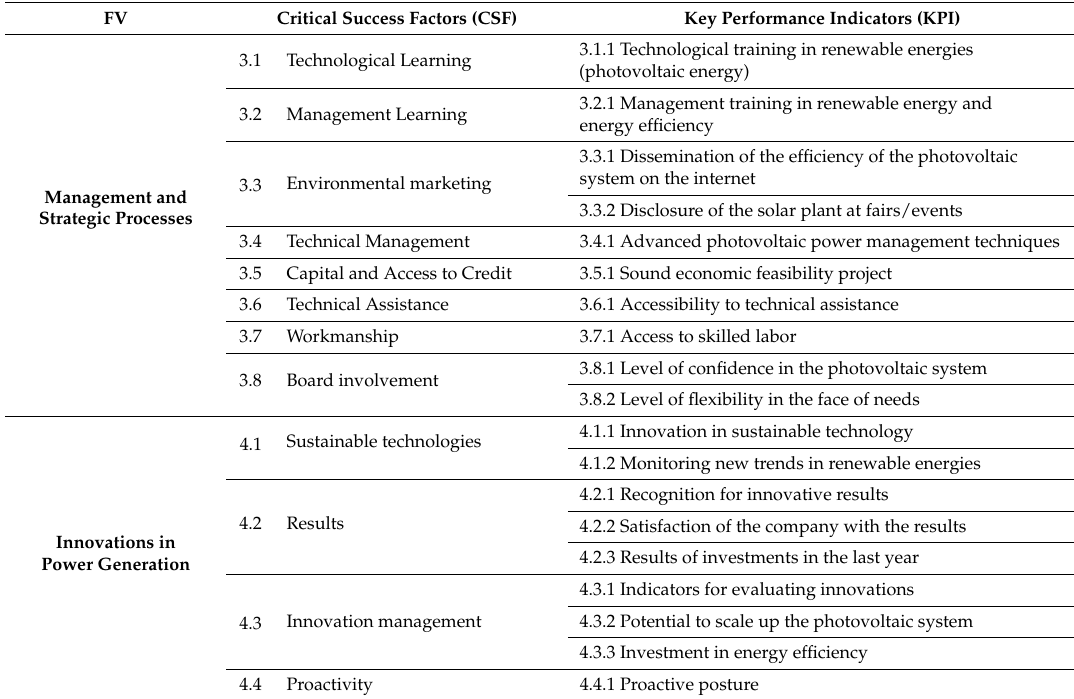
FV Critical Success Factors (CSF) Key Performance Indicators